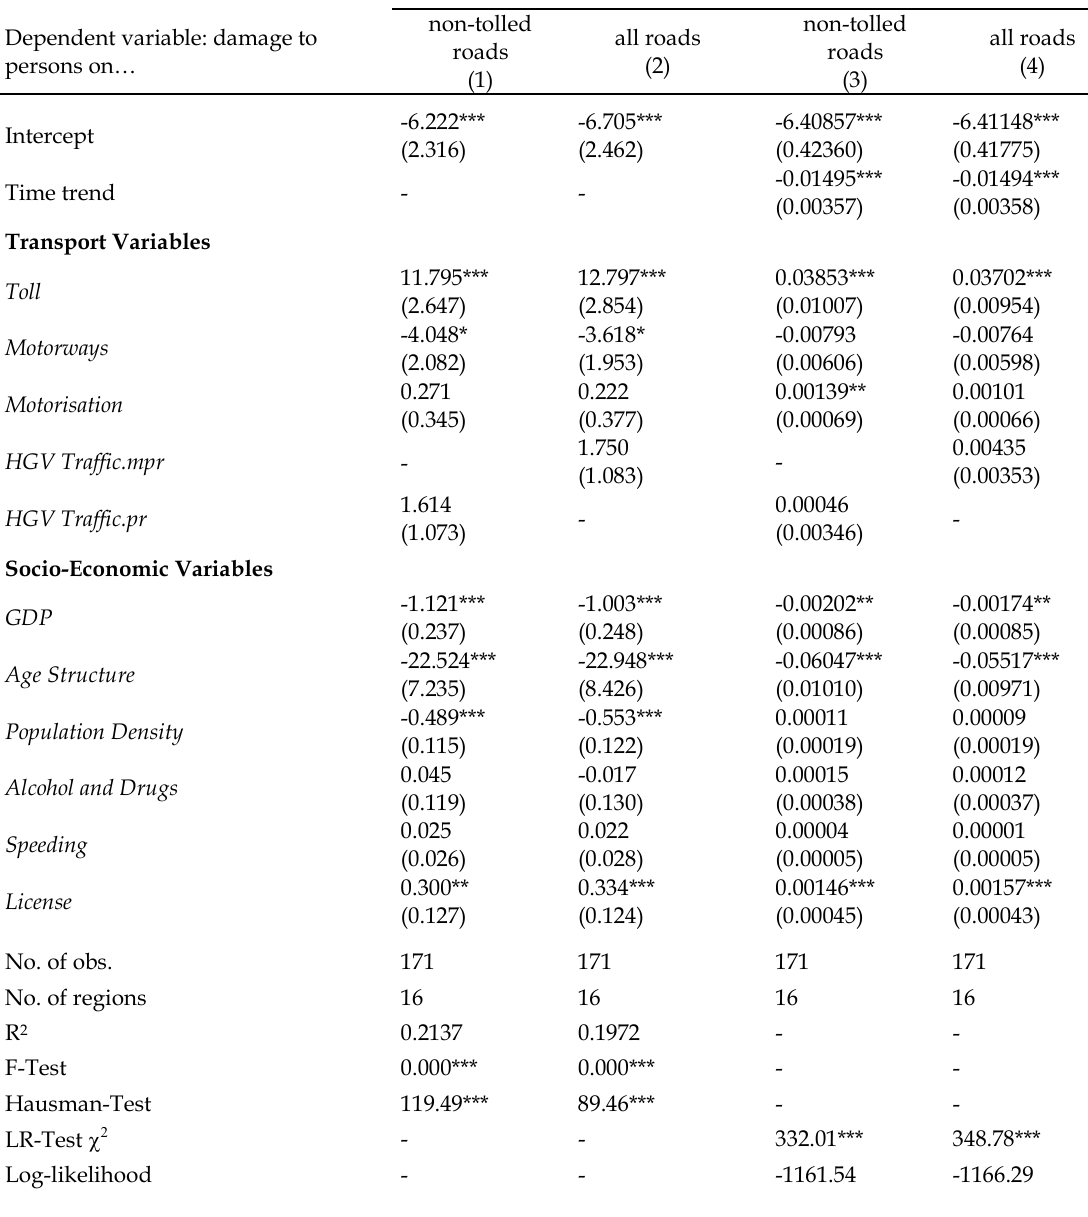
Table 4. Estimation